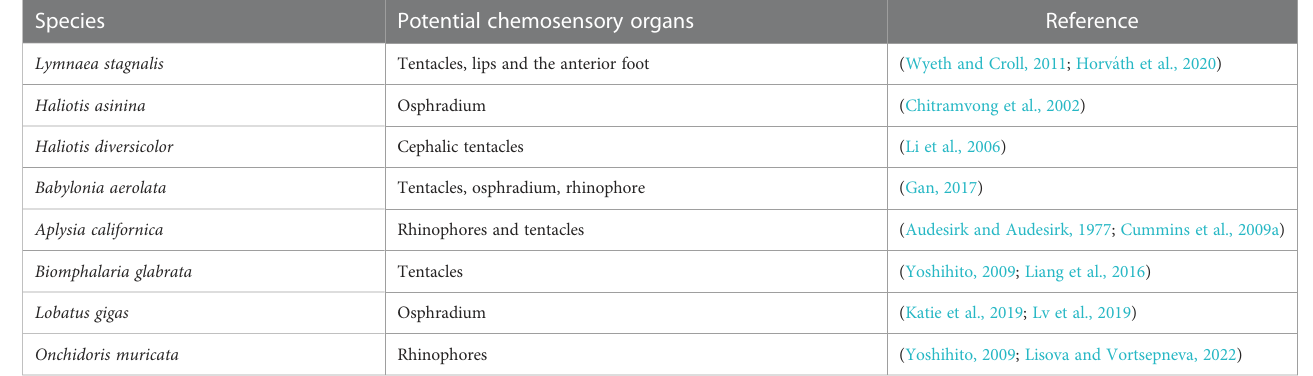
TABLE 2 Potential chemosensory organs in